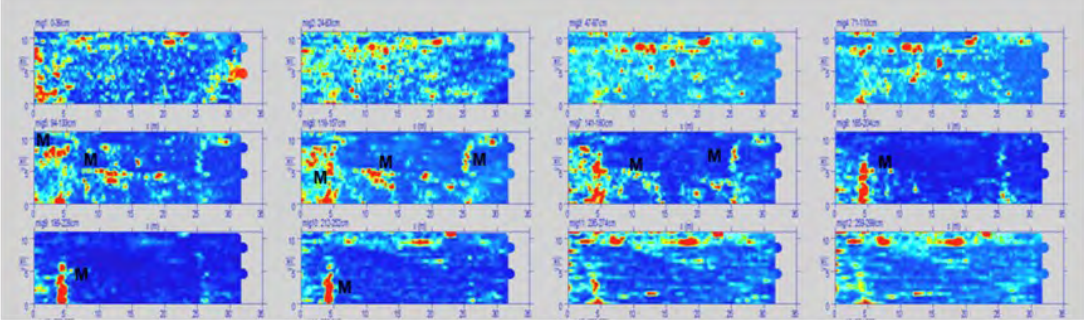
Figure 5. Time slices: M indicates alignments relating to walls.